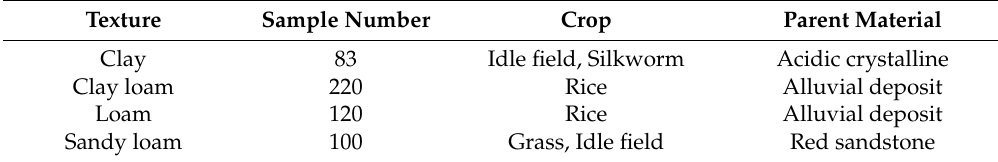
Figure 1. Location of sampling sites. Table 1. Basic properties of the soil samples in the middle-lower Yangtze